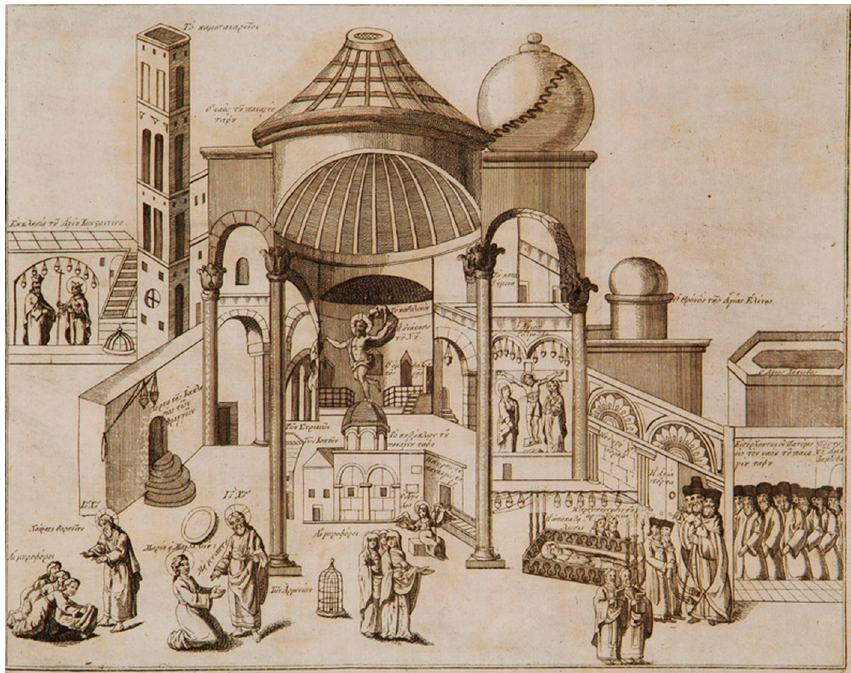
Figure 13. A fine example of the cavalier perspective in depictions of Mecca and (pictured here), Medina, from a 1738–1739 copy by one Mu ḥ ammad al-Shahr ī . Bibliothèque nationale de France, Département des manuscrits, Arabe 6859, f. 22v.